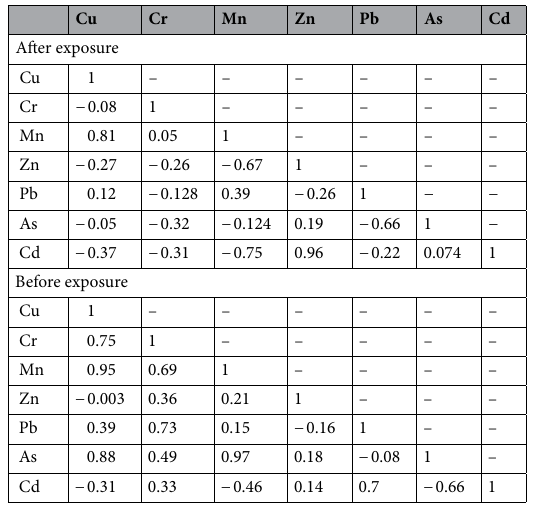
Table 3. The correlations between heavy metals on the surface of PM 10 .